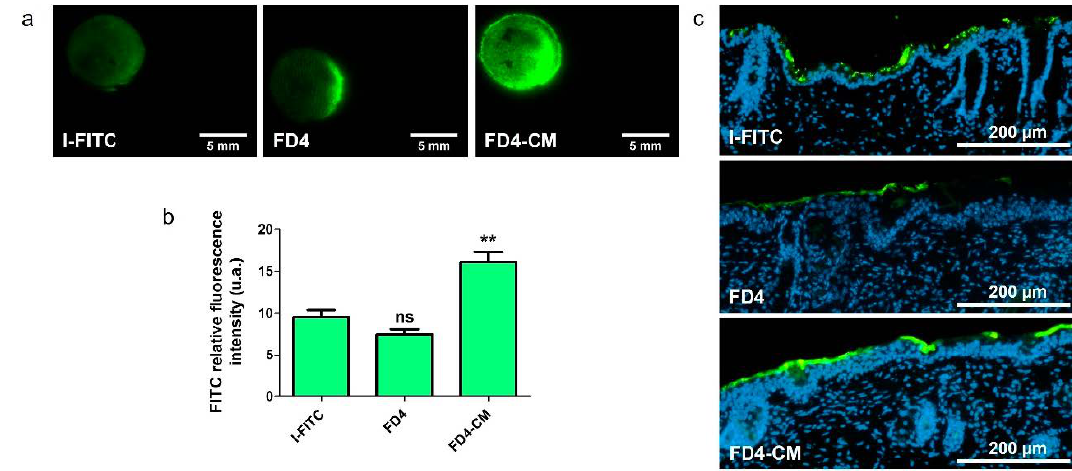
Figure 6. Comparison of FITC labelled insulin (I-FITC) with FD4 and FD4-CM behavior during delivery through skin EP. Platforms loaded with either I-FITC, FD4 or FD4-CM (1 mM), were used to apply unipolar EP treatment on hairless mice skin explants. Skins were imaged 30 min after. ( a ) Delivery pattern of I-FITC, FD4 and FD4-CM loaded in platforms after treatment with unipolar pulsed electric field. ( b ) Quantification of FITC RFI of the three molecules at the cathode of treated skin. Statistical analysis: one-way ANOVA, Dunnett post-test vs. I-FITC data. (Codes signification: ** = p > 0.01; ns = non-significant). n = 3–9. ( c ) Histological observations of 10 µm slices of skin treated with EP using platforms loaded with either FD4, FD4-CM or I-FITC. Only the cathodes are displayed. FITC is green and nuclei are labelled in blue by DAPI.